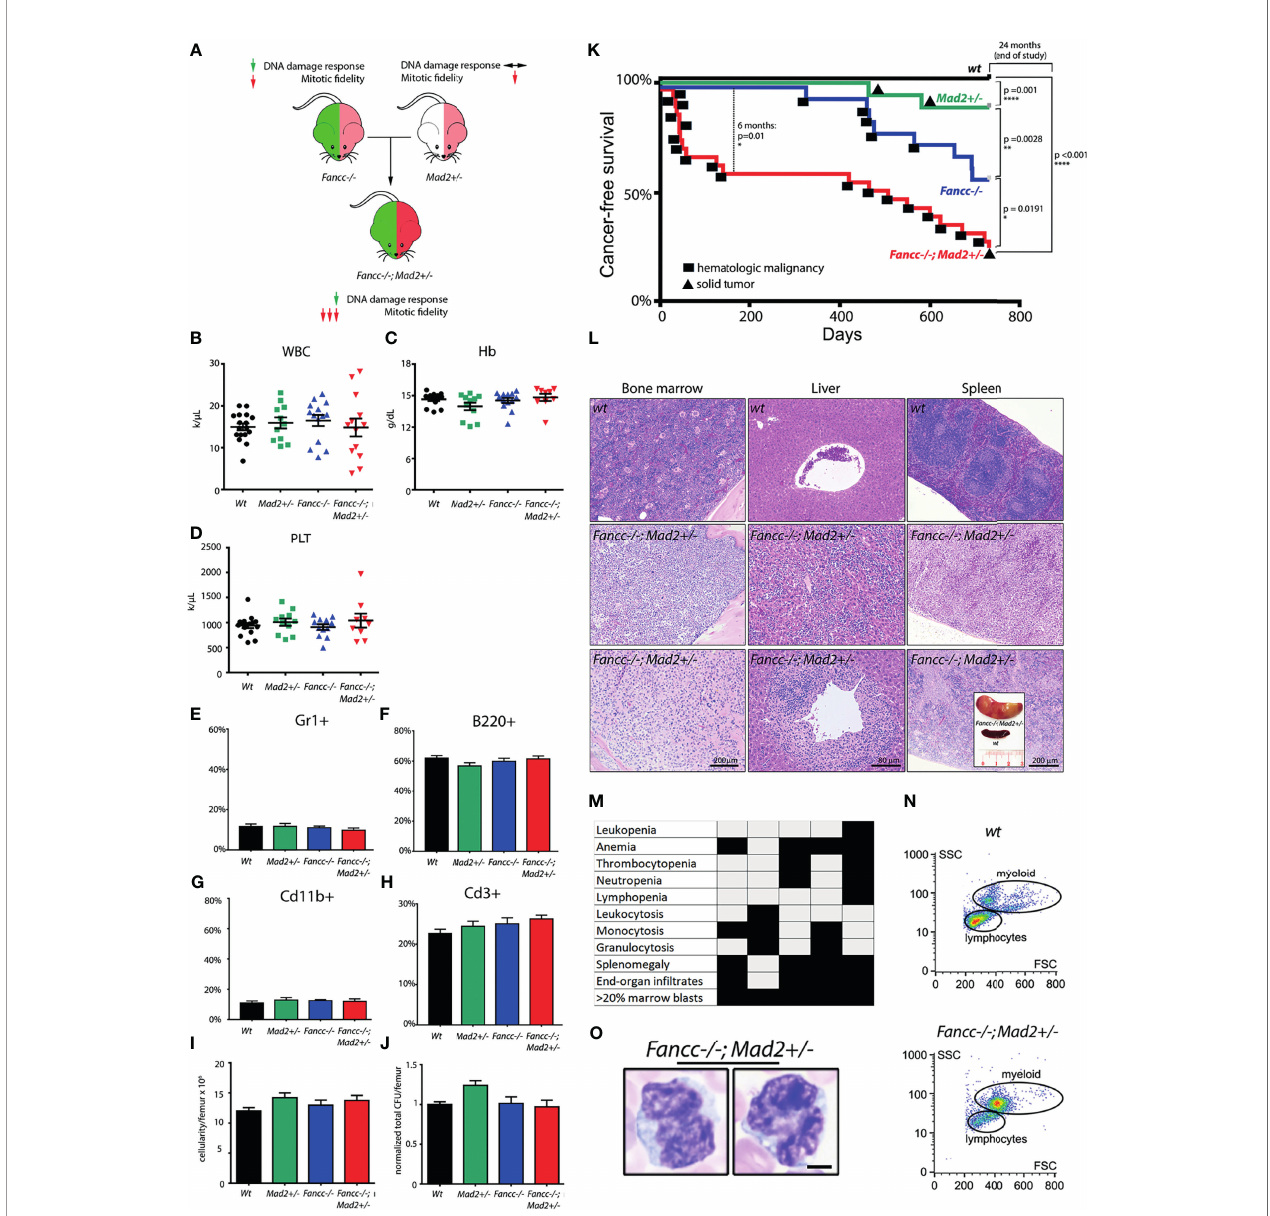
FIGURE 1 | Fancc-/-; Mad2+/- mice suffer from premature death and abnormal hematopoiesis. (A) Experimental design. Mad2 heterozygosity in Fancc-/- background is hypothesized to exacerbate mitotic abnormalities but not DNA damage repair response. Normal total white blood count (B) , hemoglobin (C) , platelet count (D) , percentage of Cd11b+ and Gr1+ myeloid cells (E, G) and B220+ and Cd3+ lymphoid cells (F, H) in the peripheral blood of healthy-appearing Fancc-/-; Mad2+/- mice compared to age/sex-matched wt , Mad2+/- and Fancc-/- mice at 2-3 months of age. Well-appearing 16-week old Fancc-/-; Mad2+/- mice had the same bone marrow cellularity (I) and were able to form the same number of colonies in methylcellulose-based colony forming assays supplemented with progenitor growth factors (see Methods ) (J) as age/sex-matched wt , Fancc-/- and Mad2+/- controls. Statistical analysis was performed by one-way ANOVA with Dunnett ’ s multiple comparison correction. No statistically signi fi cant differences were found. (K) Decreased cancer-free survival in Fancc-/-; Mad2+/- mice compared to wt, Mad2+/- and Fancc-/- age/sex-matched controls. Kaplan-Meier curves with p values determined by log-rank Mantel-Cox tests at 6-month and 24-month time points (n ≥ 17 mice per genotype) are shown. Squares denote death due to hematopoietic malignancies; circles represent deaths from solid tumors. (L) Bone marrow, liver, and spleen in fi ltrates in representative Fancc-/-; Mad2+/- mice compared to wt controls. Insert (lower right) shows nodular splenomegaly in a representative leukemic Fancc-/-; Mad2+/- mouse. (M) Histopathological evidence of fi ndings consistent with leukemia in fi ve representative Fancc-/-; Mad2+/- mice. (N) fl ow cytometry demonstrating increased populations of large myeloid cells in a representative moribund Fancc-/-; Mad2+/- mouse. (O) Large myeloid blast cells, characterized by increased nucleus-to-cytoplasm ratio, irregular nuclei, and open chromatin from the peripheral blood. *p < 0.05, **p < 0.01, ****p <